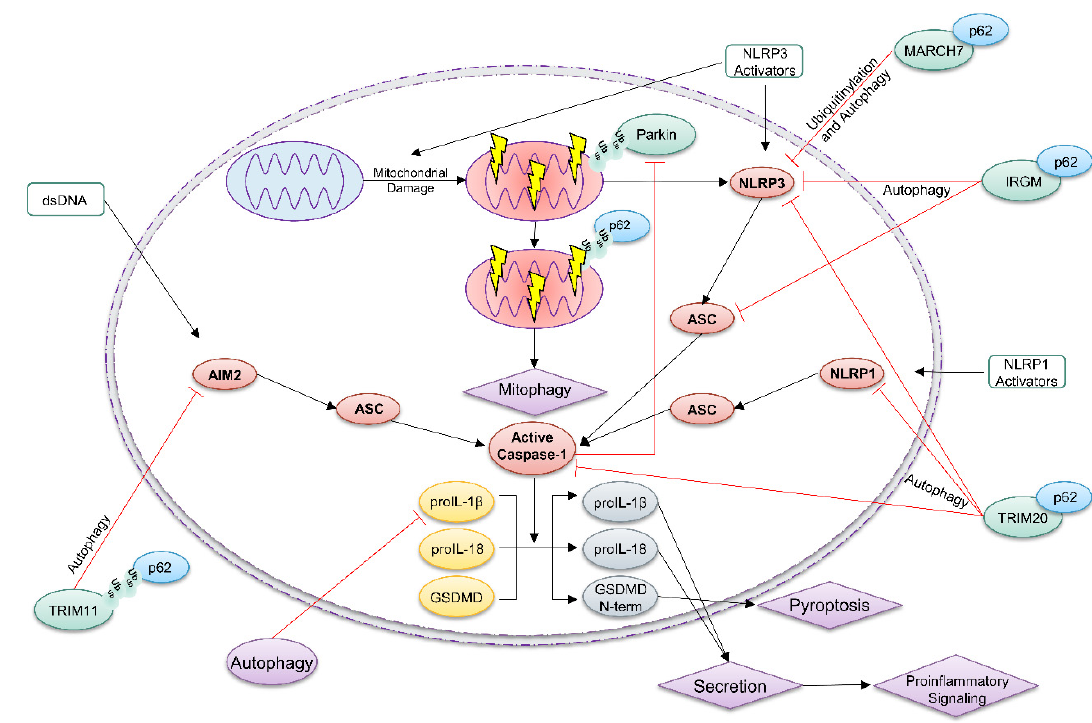
Figure 3. p62-dependent autophagy antagonizes inflammasomes. The inflammasome sensors NLRP3, NLRP1 and AIM2 sense certain stressors, which induce their activation. This causes oligomerization of the adaptor protein ASC (speck formation) and in turn activation of the protease caspase-1 [81]. Subsequently, caspase-1 activates the proinflammatory cytokine proIL-1 β and -18 by proteolytic processing. Release of mature IL-1 β and -18 induces an inflammatory response, which is dependent on caspase-1-dependent cleavage and activation of GSDMD. p62 is required for mitophagy of damaged mitochondria that induce NLRP3 activation [90]. Moreover, MARCH7 ubiquitinates NLRP3, inducing its p62-dependent selective autophagic degradation [91]. Together with p62, IRGM regulates degradation of NLRP3 and ASC via autophagy [92]. The E3 ubiquitin ligase TRIM20 ubiquitinates NLRP3, NLRP1 and caspase-1, thereby initiating their p62-dependent autophagic clearance [93]. Ubiquitinated TRIM11 binds with p62 to AIM2 causing its degradation by autophagy [94].